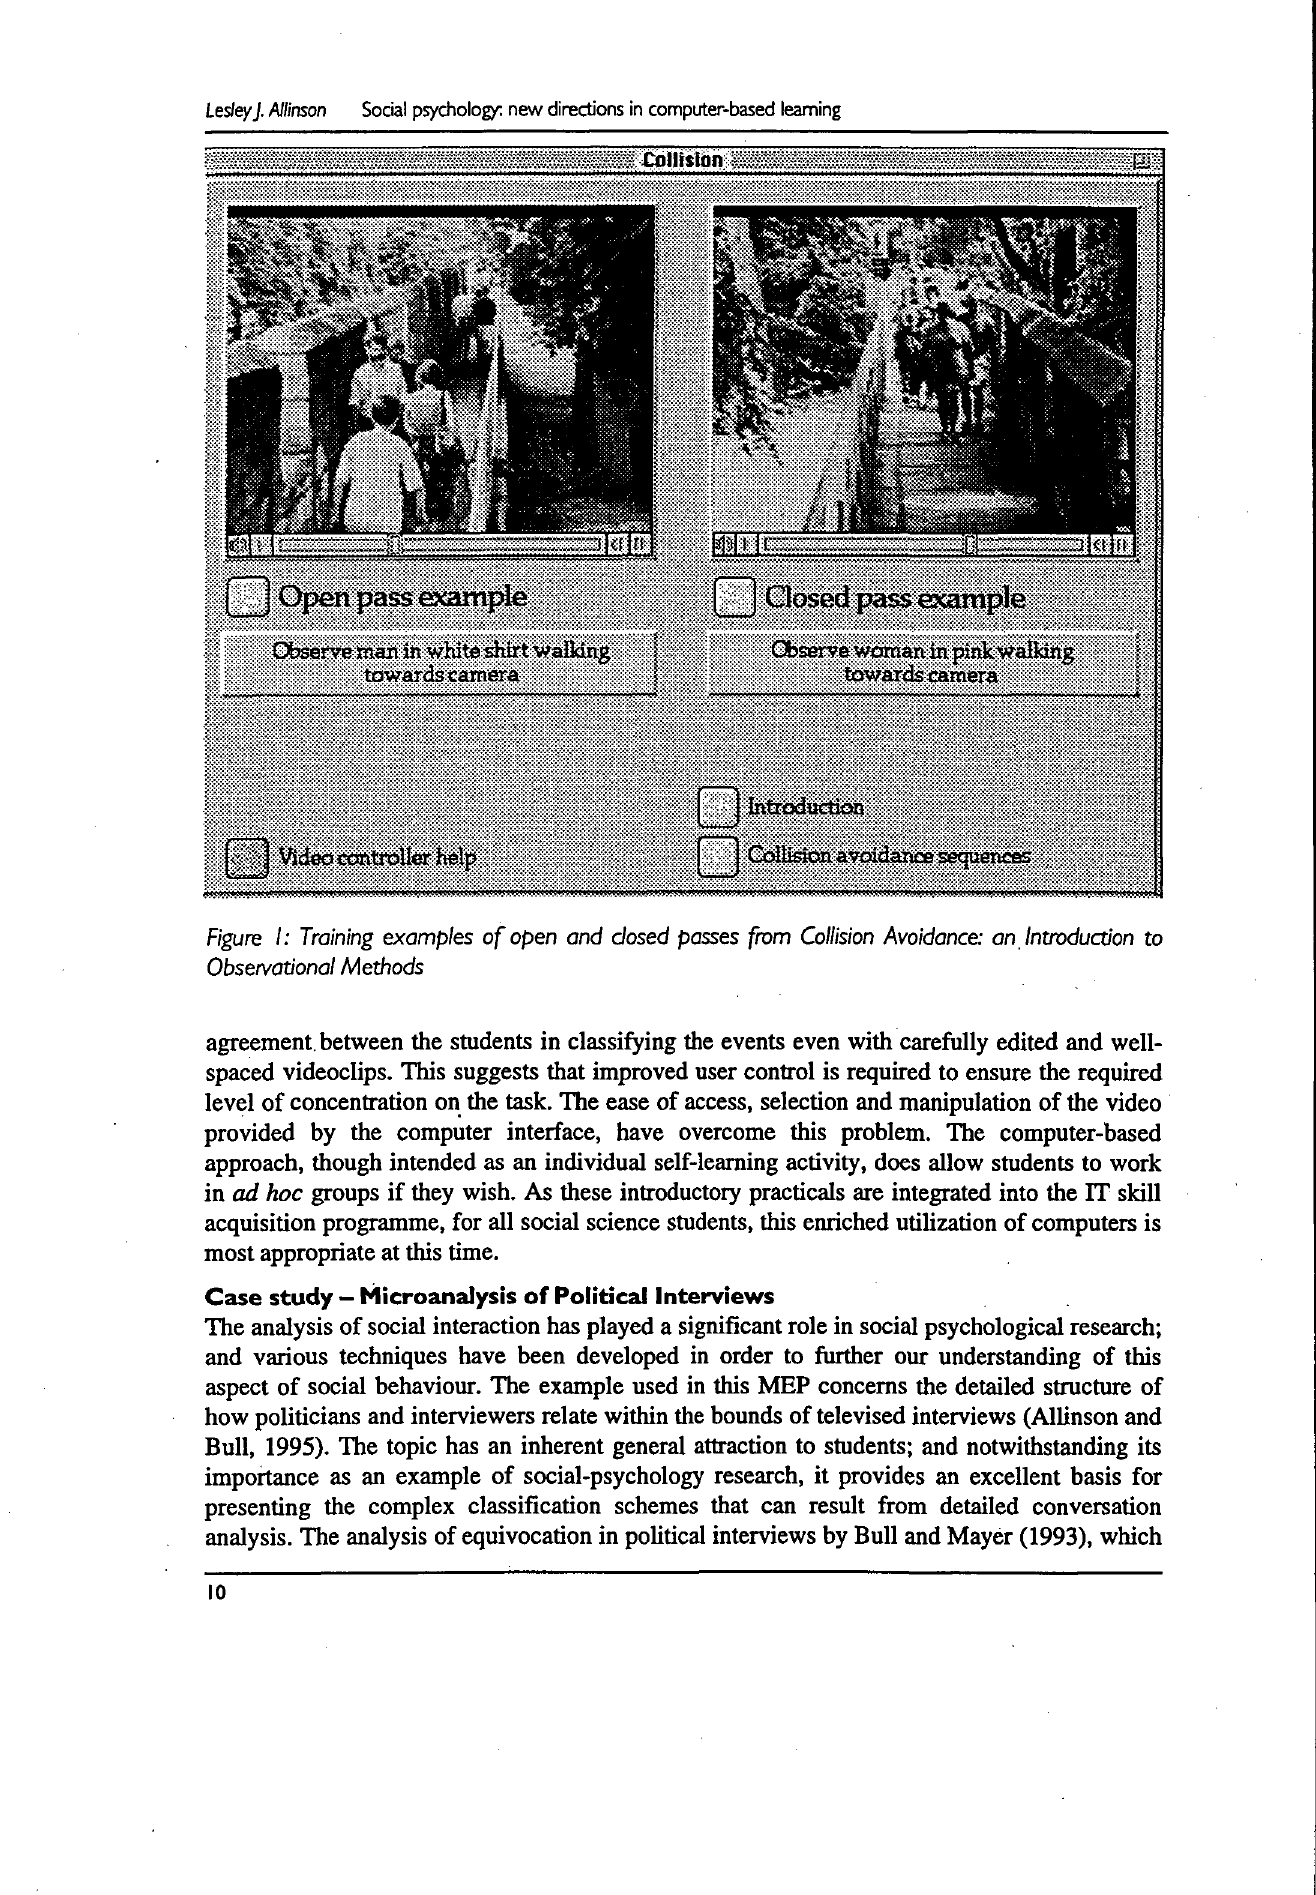
figure /: Training examples of open and dosed passes from Collision Avoidance: an Introduction to Observational